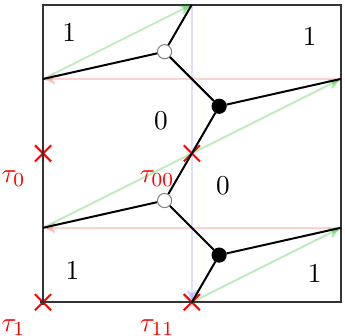
Figure 3. The brane tiling of C 2 / Z 2 × C with the four fixed points of the orientifold projection.